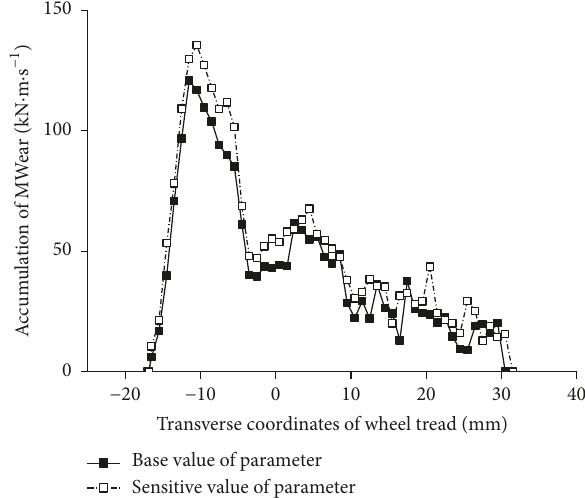
Figure 7: Influence of vertical stiffness of the track on the cumula- tive wear power dissipation of the wheel.